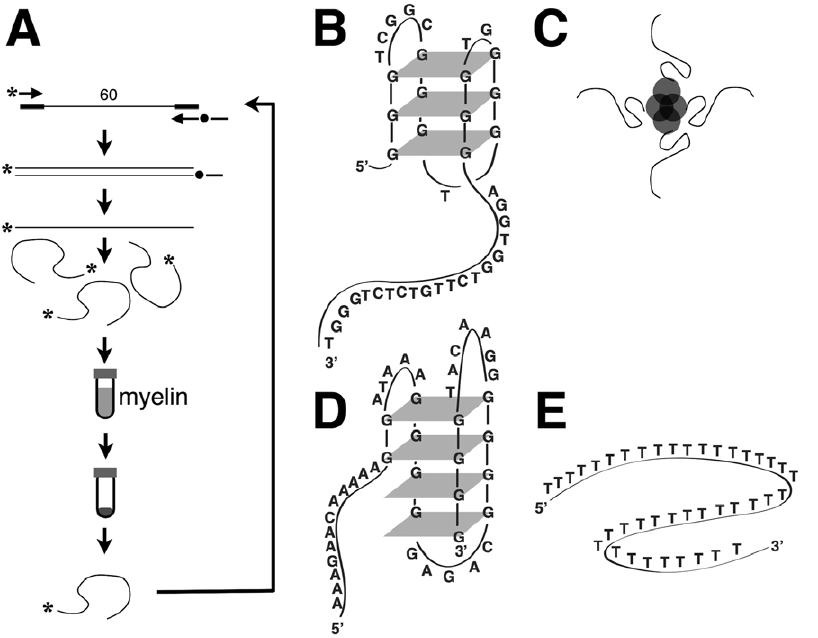
Figure 1. Selection of DNA aptamers specific for components of crude mouse myelin suspension. A. A pool of . 10 12 100-nucleotide fluorescent (*) single-stranded DNA aptamers containing 60 nucleotides of random sequence is generated by a PCR and mixed with a suspension of crude mouse myelin. Cycles of affinity purification and amplification (Figure S1, S2, S3, S4) yield long myelin-specific DNA aptamers from which active sub-sequences can be derived. B. Deoxyguanosine-rich DNA aptamer 3064 specific for crude mouse myelin, shown folded as a putative intramolecular G-quadruplex. C. Tetravalent complex of 3-biotinylated DNA aptamer (thin lines) with streptavidin (circles). D. Negative control deoxyguanosine-rich DNA aptamer 3060 specific for chelated Nickel ions, shown as putative intramolecular G-quadruplex. E. Negative control oligodeoxythymidylate 3202.